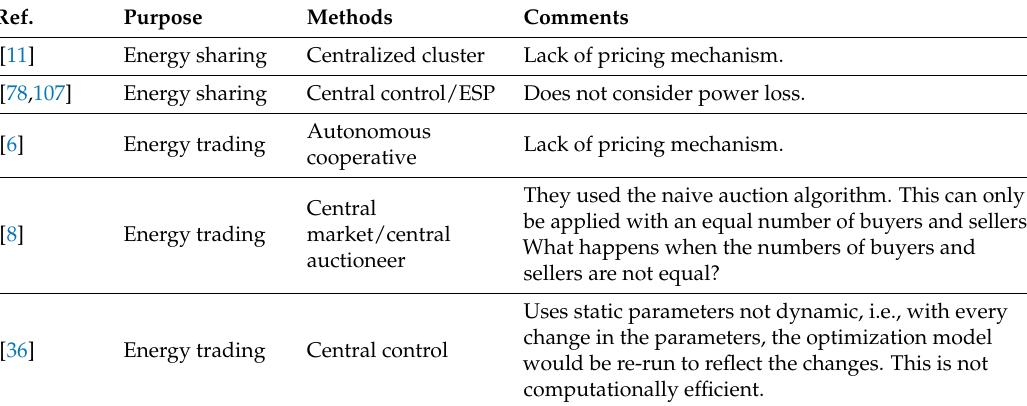
Table 3. Drawbacks of some methods used in the